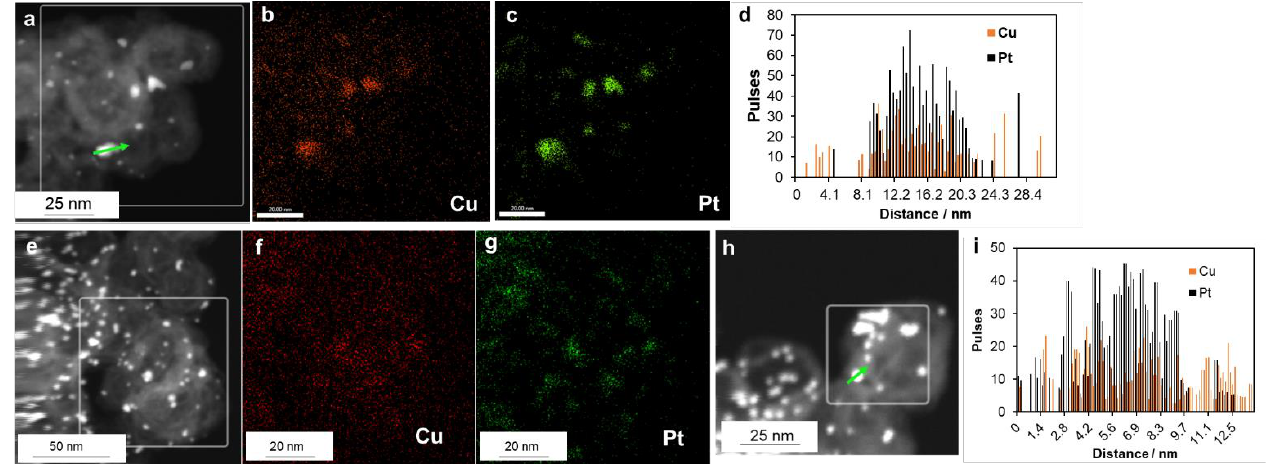
Figure 3. STEM images of bimetallic catalysts ( a , e , h ). The green arrow shows the direction of the EDX line scanning of the NPs ( a , h ). Elemental mapping of PtCu/KB ( b , c ) and PtCu/KB-N ( f , g ). EDS line scan of NPs for the PtCu/KB ( d ) and PtCu/KB-N ( i ) samples.